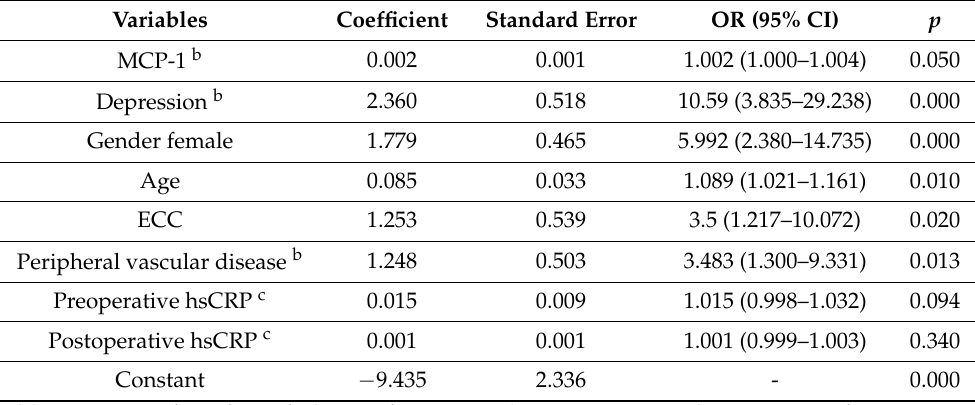
Table 4. Factors independently associated with delirium after cardiac surgery revealed in multivari- able stepwise logistic regression analysis a